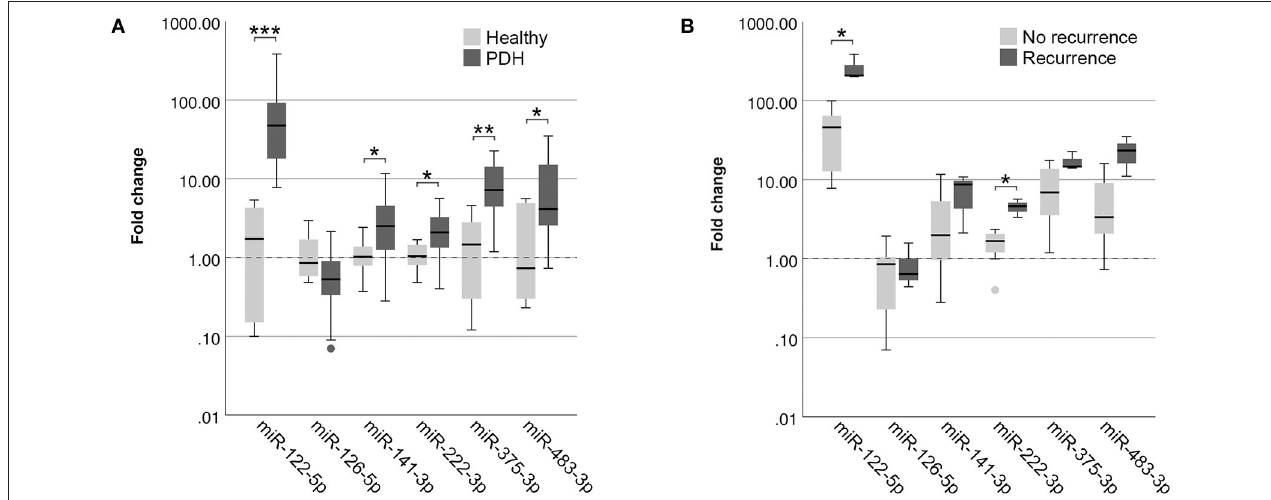
FIGURE 3 | Circulating miRNA expression levels in EDTA plasma samples, normalized with only miR-191-5p, in (A) dogs with PDH ( n = 19) and healthy dogs ( n = 6); and (B) dogs with PDH with ( n = 3) or without ( n = 7) recurrence of hypercortisolism within a year after hypophysectomy. Circles below boxes indicate outliers. * p < 0.05; ** p < 0.01; *** p < 0.001. PDH, pituitary-dependent